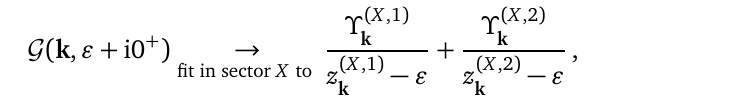
Figure 6: Bogoliubov coefficients in the BCS regime ( µ/ ∆ = 4, 1 / k The altered Bogoliubov weights defined in Eq. (37) are shown in function of the wavenumber using the eigenenergy from different approximations used in our study, namely the self-consistent (red line) and perturbative (blue dashed line) solutions. The corrected coefficients are shifted with respect to the BCS result (black dotted line), in the same way as the minimum of the dispersion (see Fig.